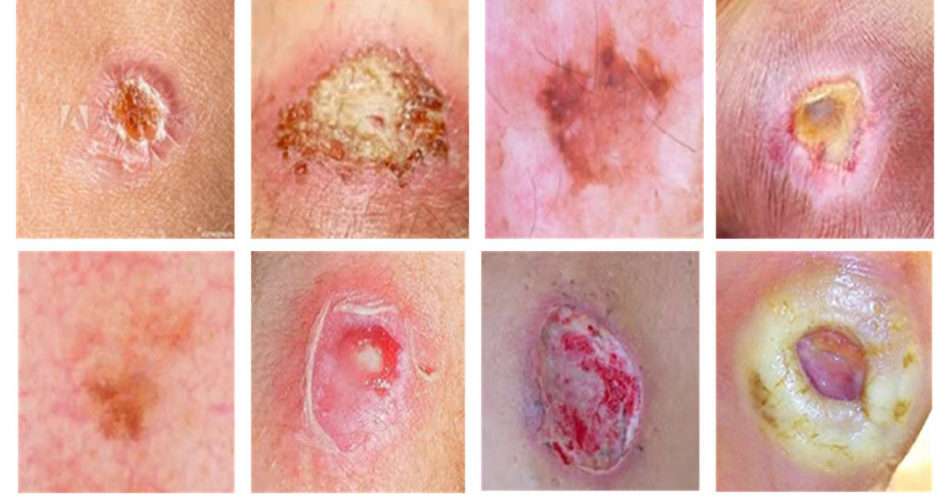
Figure 3. Samples from the medical dataset (Dataset C).